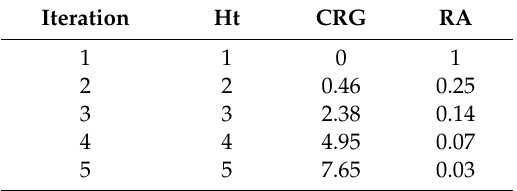
Table 1. The three metrics under the new fractal definition at each iteration of the Koch